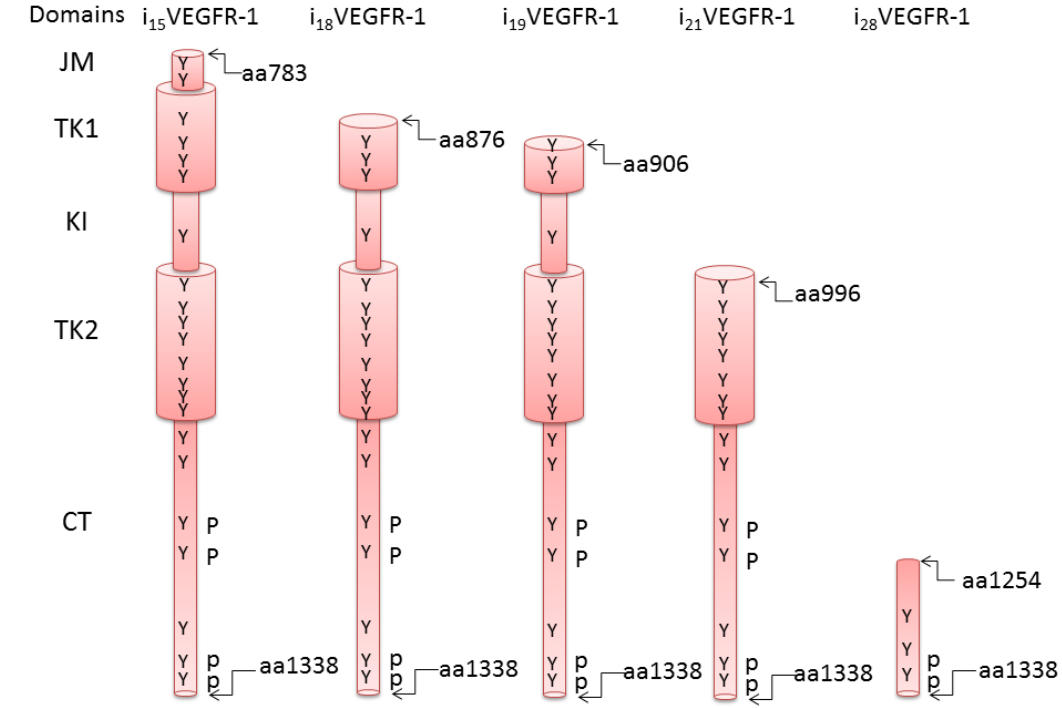
Figure 2. Schematic structure of the intracellular truncated isoforms of VEGFR-1.